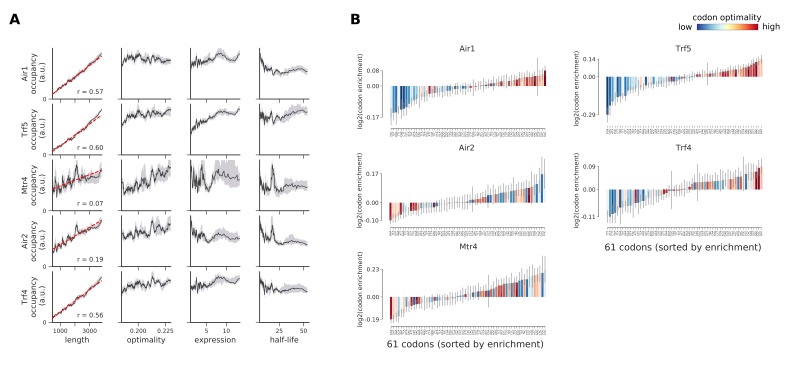
Occupancies for components of the TRAMP complex (Air1, Trf5, Mtr4, Air2, and Trf4) compared to transcript length, optimality, expression level, and half-life.(A) To understand binding specificity of TRAMP components, the total occupancy of each factor on a transcript is plotted against various transcript features (Gray shading: 95% confidence intervals generated by bootstrapping transcripts). (B) Same analysis as in Figure 6B: Codon enrichment shows deviations in codon frequencies of transcripts bound by a degradation factor compared to each codon’s frequency on all coding sequences. Each bar is colored according to its codon-optimality with highly optimal codons in dark red and highly non-optimal codons in dark blue. (Gray lines: 90% confidence intervals generated by bootstrapping coding sequences).